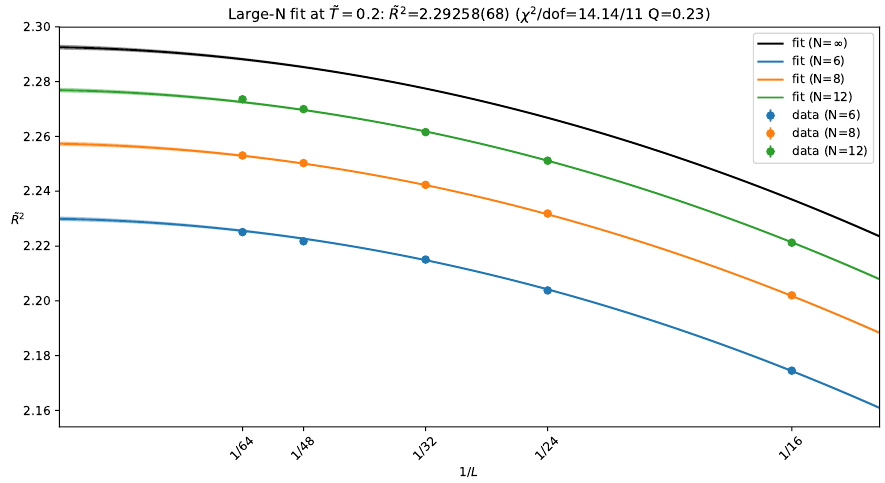
Figure 10. Continuum and large- N limit extrapolation of ~ R 2 for the bosonic ungauged matrix model at ~ T = 0 : 2. The title of the plot summarizes the large- N continuum limit value of ~ R 2 , the (cid:31) 2 with corresponding degrees of freedom, and the Q value of the (cid:12)t.